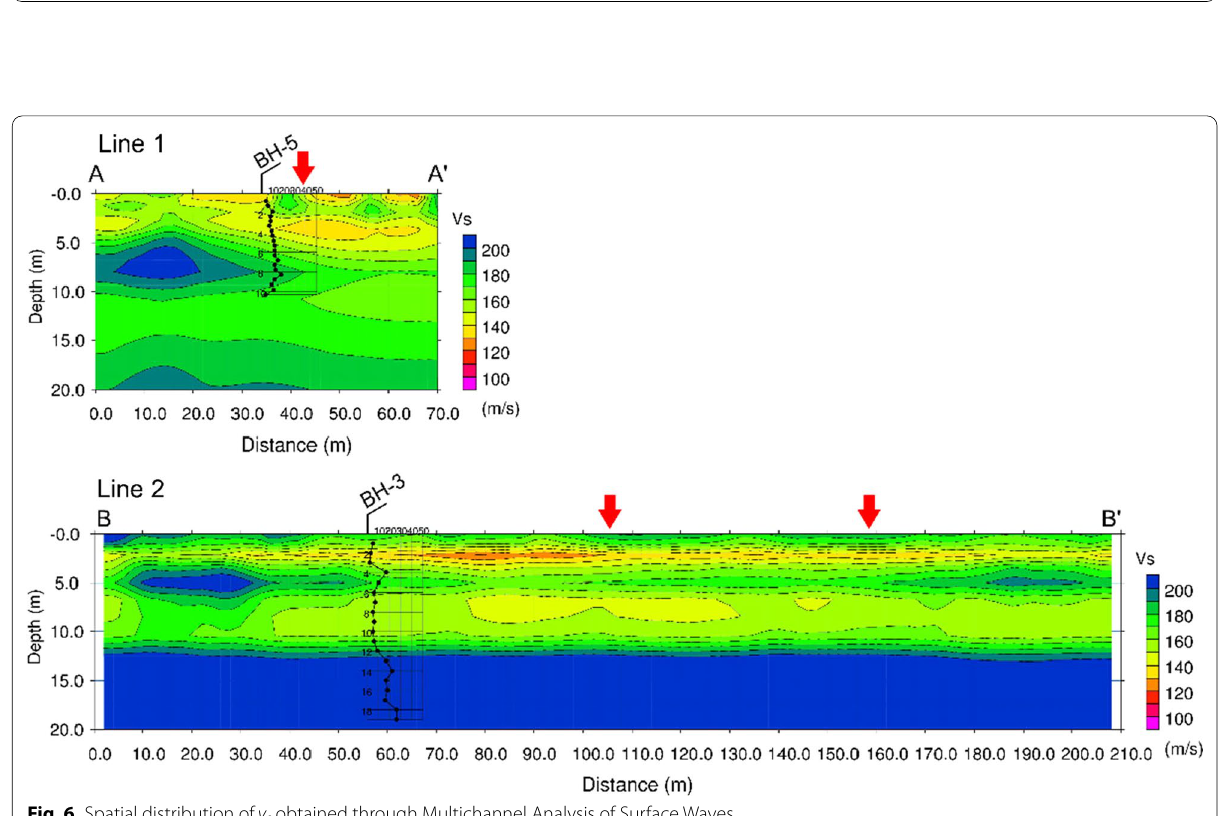
Fig. 6 Spatial distribution of v s obtained through Multichannel Analysis of Surface